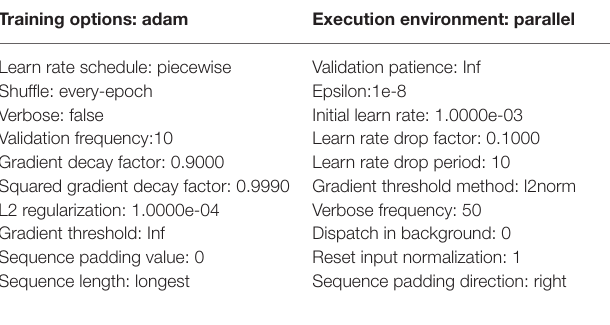
TABLE 5 | Hyperparameter optimization parameter.